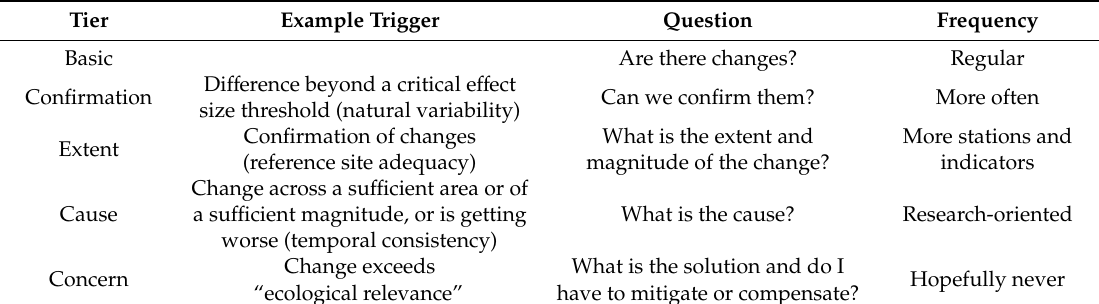
Table 5. Examples of tiers (or phases) of monitoring, similar to those used in environmental e ff ects